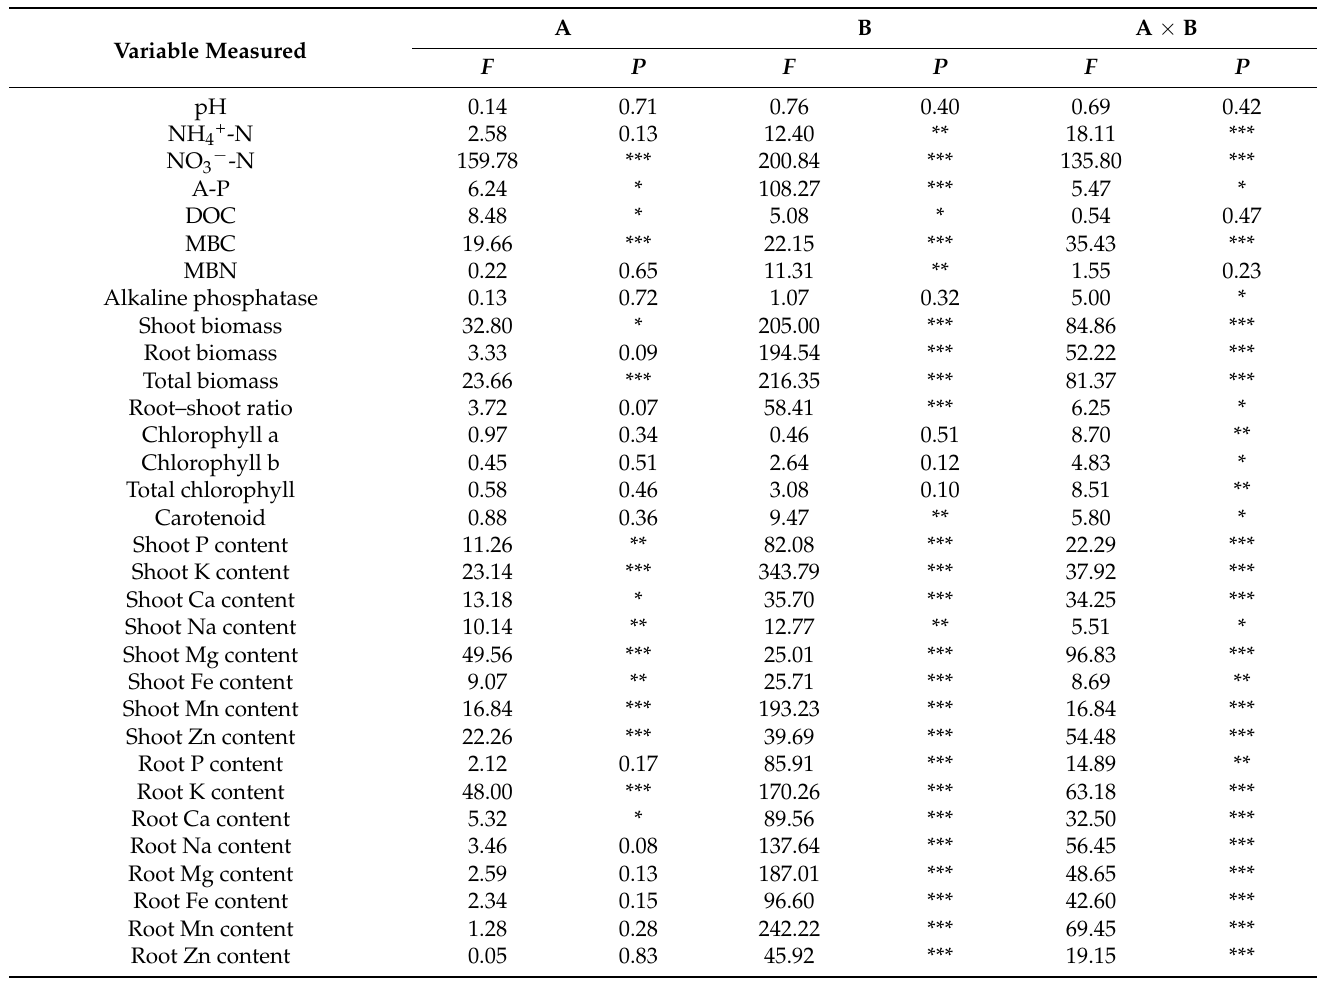
Table 2. Probabilities of significance calculated using a two-way ANOVA for the main treatment effects and treatment interactions of the measured variables.